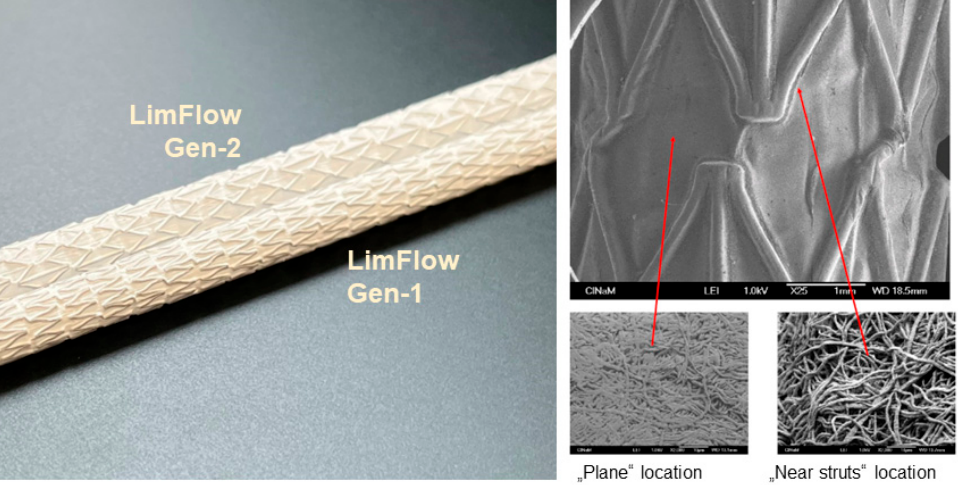
Figure 1. Images of LimFlow stent grafts. Photographic images showing LimFlow Gen-1 and Gen-2 stent grafts ( left ), and SEM images showing the surface of the LimFlow Gen-2 stent grafts ( right ).